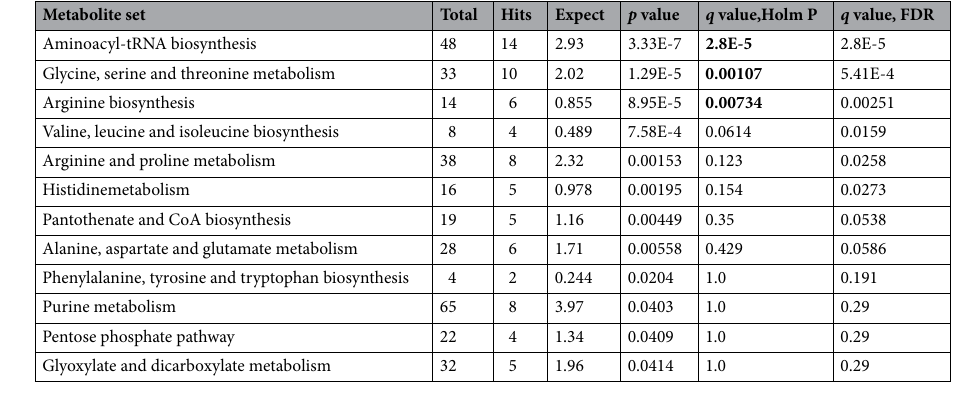
Table 3. Analysis of KEGG metabolic pathway overrepresentation. Significant values ( q < 0.05) are in bold.